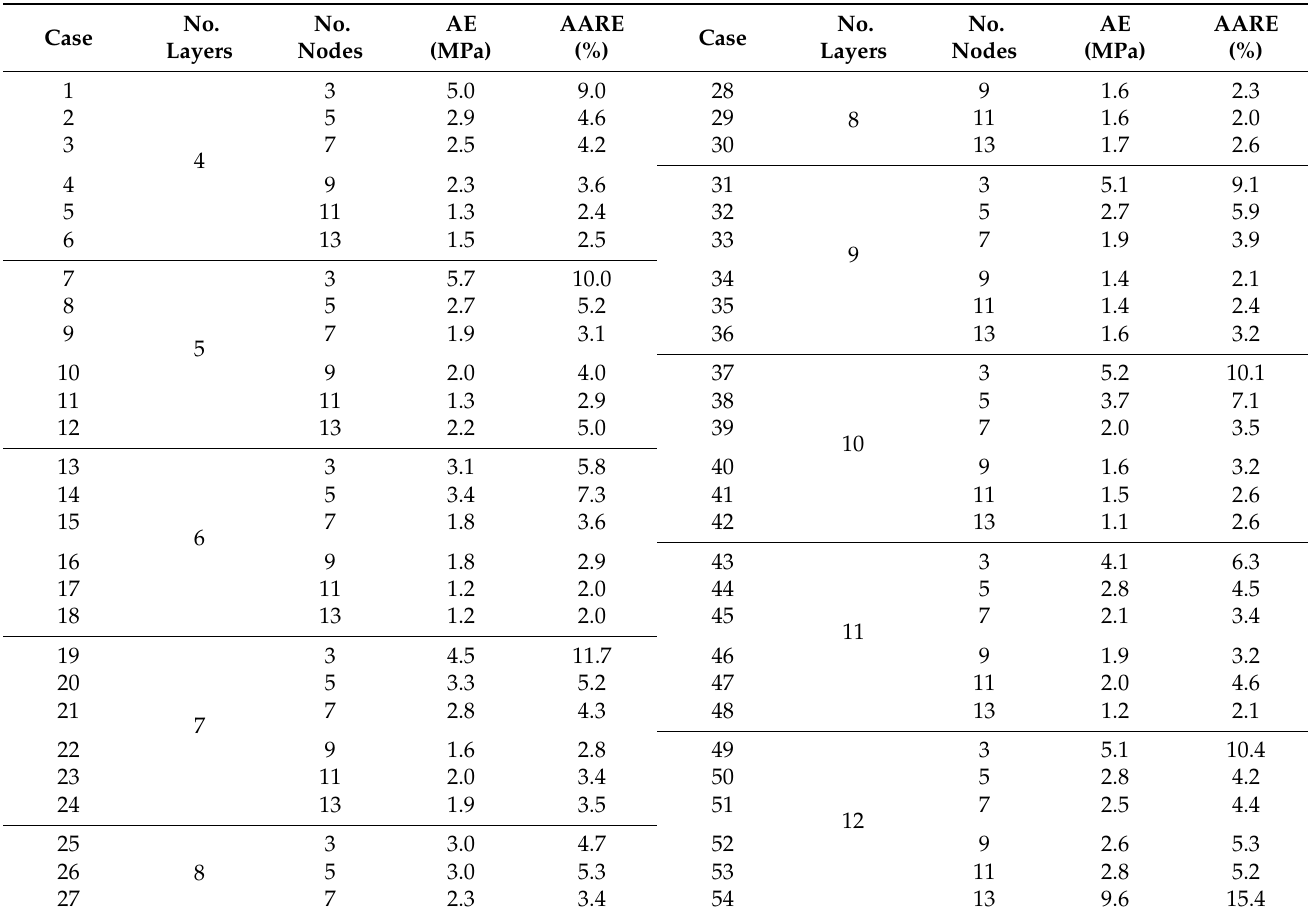
Table 4. Results of the ANN prediction according to the number of layers and